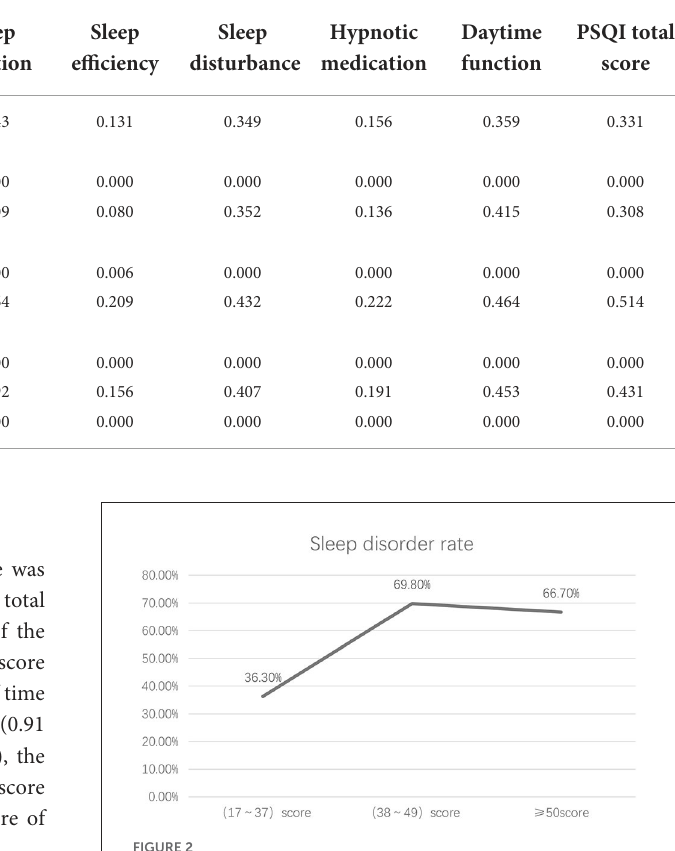
TABLE 2 Correlation analysis between PTSD and PSQI dimension scores ( n = 1,173). Variable Item Sleep